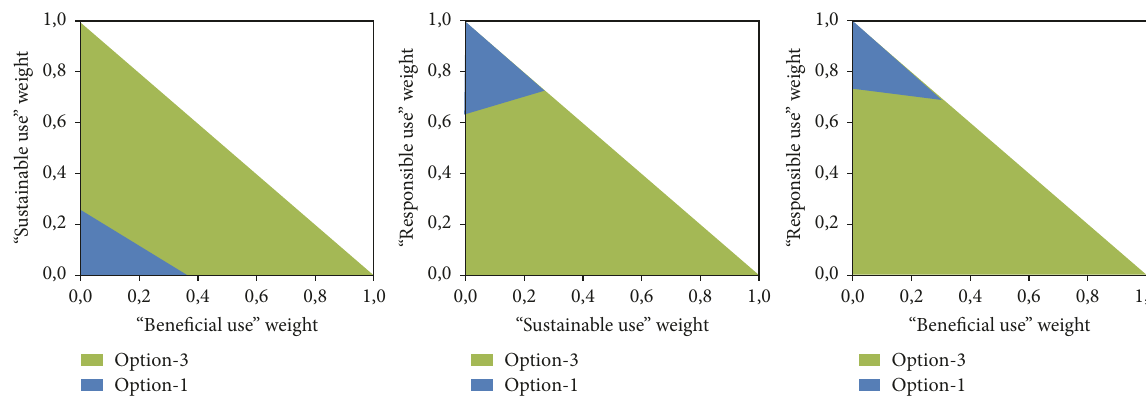
Figure 5: Results of a sensitivity analysis with regard to high-level objectives